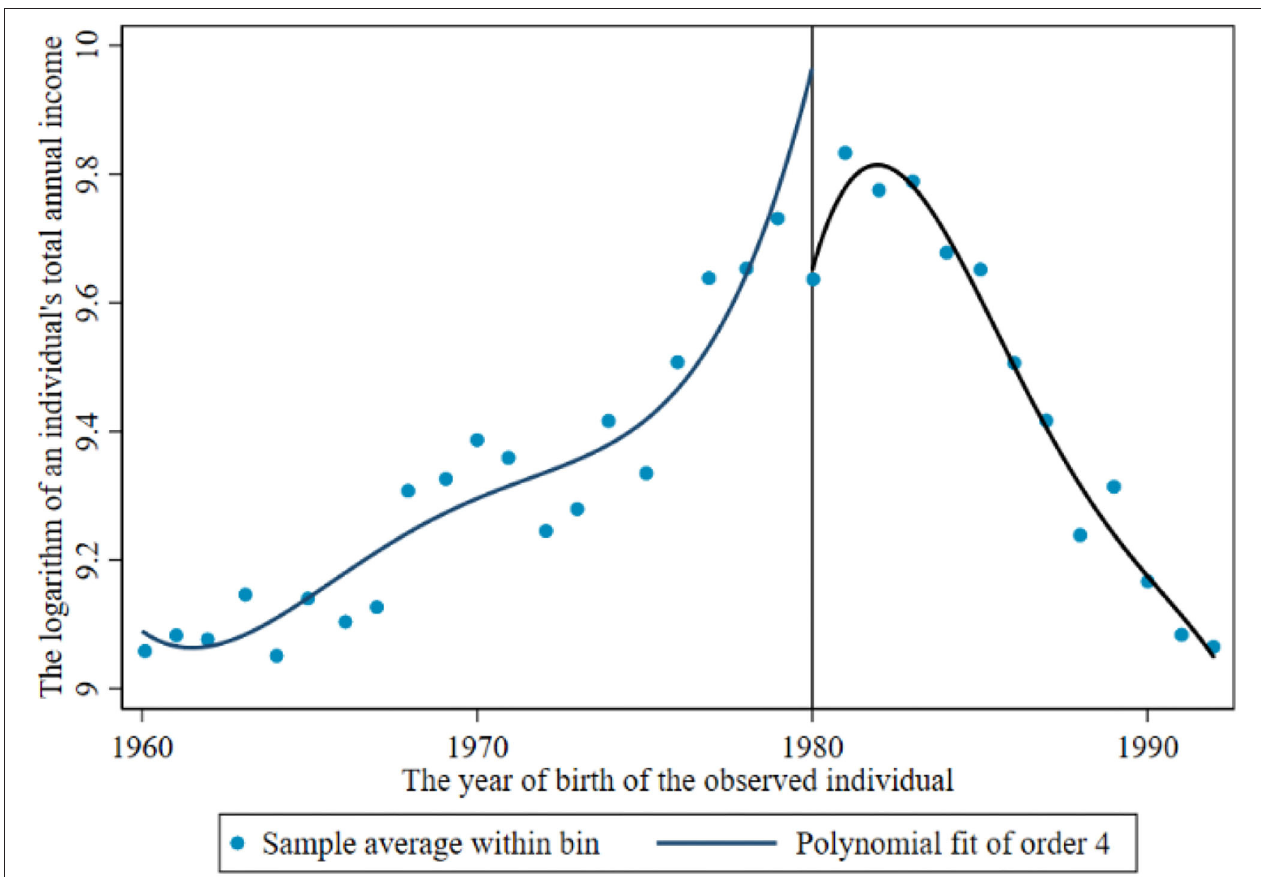
FIGURE 1 | Income breakpoint of rural residents before and after the implementation of the reproductive health policy.